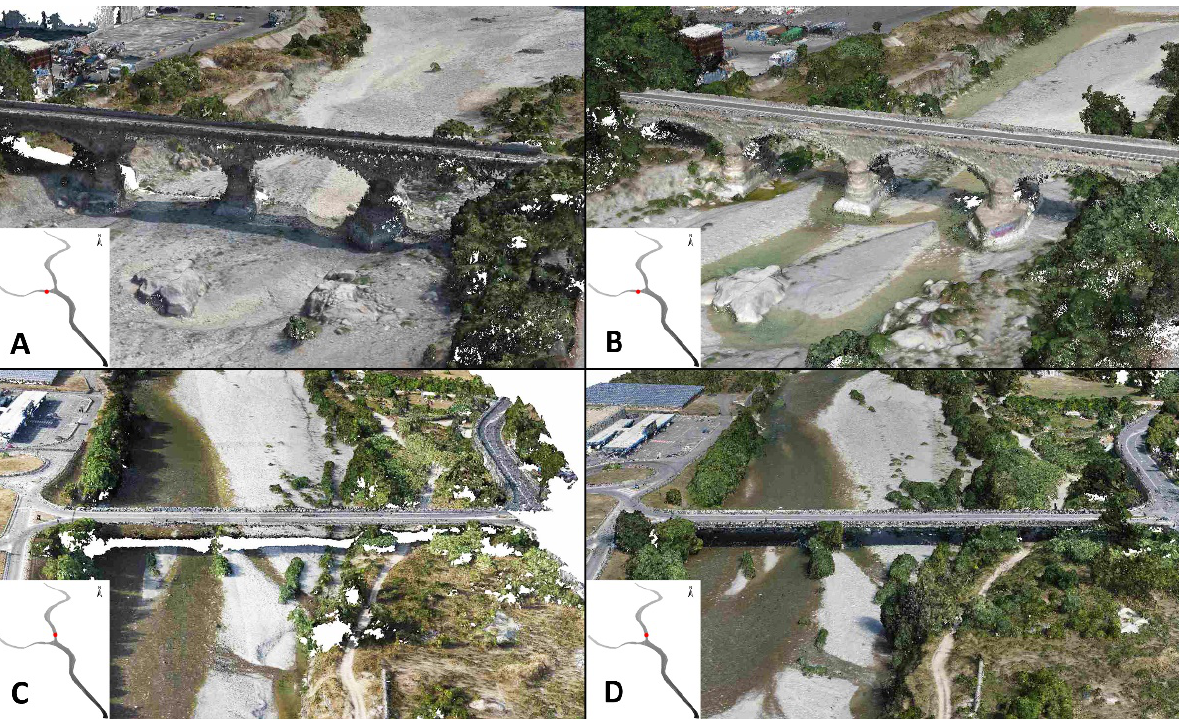
Figure 6. ( A , B ) 3D point cloud of a bridge crossing the Bevera Torrent acquired in 2017 ( A ) and 2018 ( B ); ( C , D ) 3D point cloud of a bridge crossing the Roia River acquired in 2017 ( A ) and 2018 ( B ).